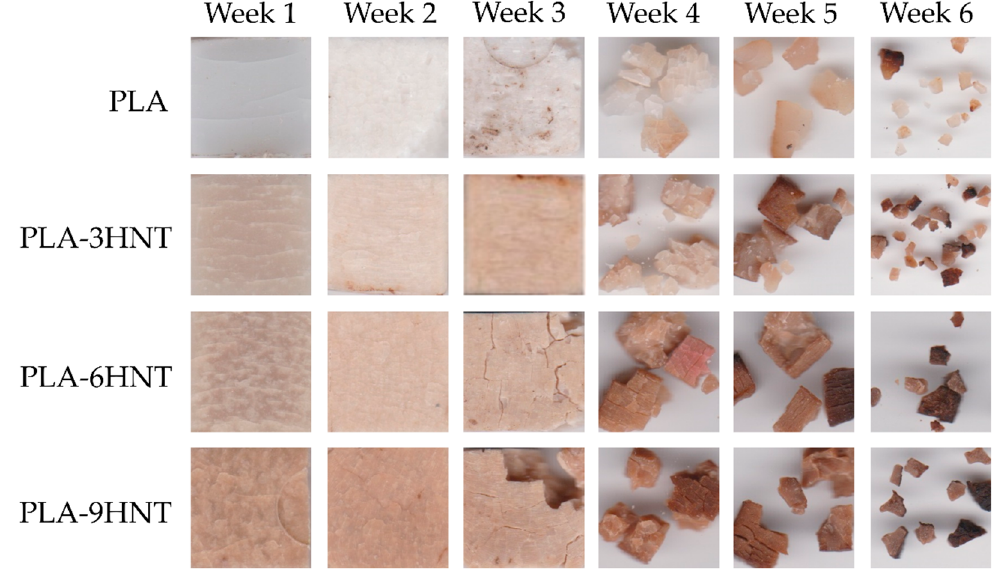
Figure 10. Optical images of the disintegration in controlled compost soil of PLA-HNT composites with different HNTs loading.